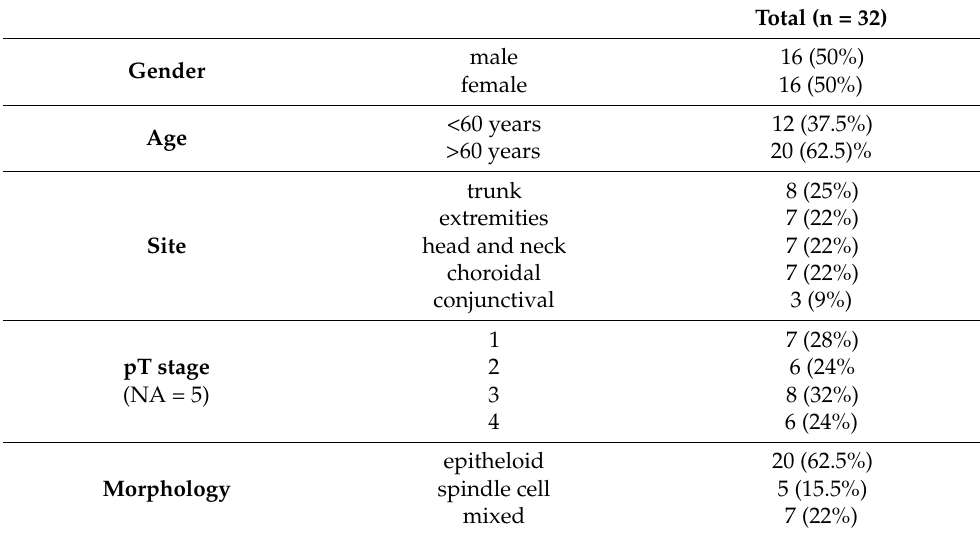
Table 1. Characteristics of the primary melanoma cases stained for PMCA4.